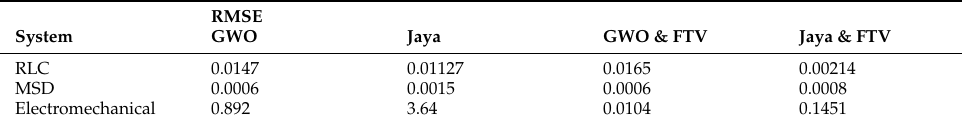
Table 3. Numerical results for second-order systems.